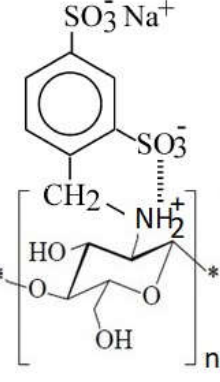
Figure 17. Schematic intramolecular interaction in chitosan sulfonated derivatives.